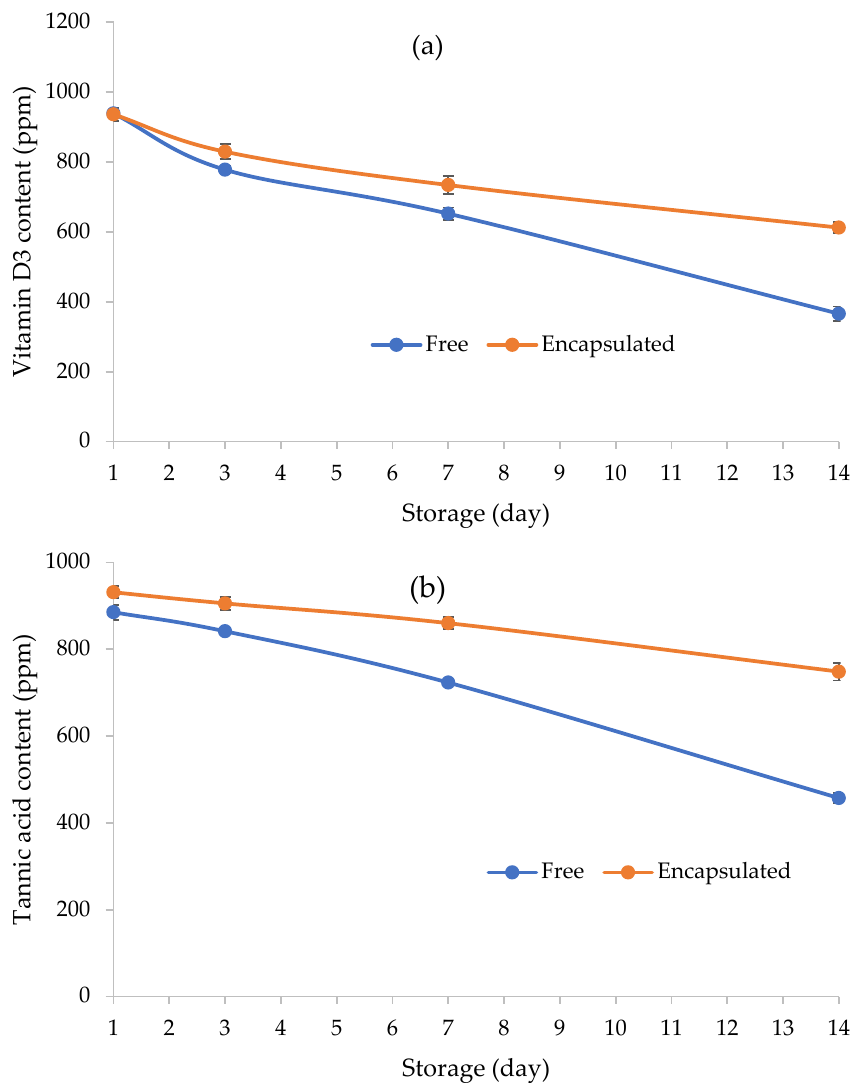
Figure 10. The stability of vitamin D 3 ( a ) and tannic acid ( b ) in the modified BSG film in encapsulated form in nanophytosome and free form over storage time (day).